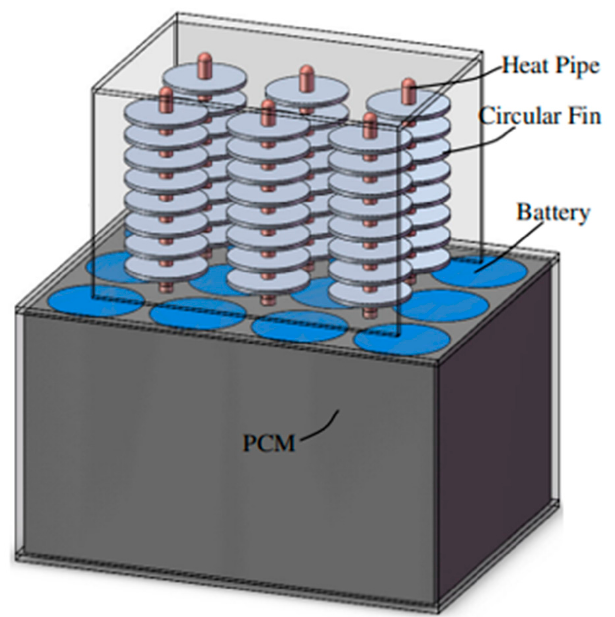
Figure 15. Thermal management model of battery coupled with heat pipe and phase change mate- rial [97]. Reproduced from reference [97] with permission from Elsevier B.V., copyright 2017.